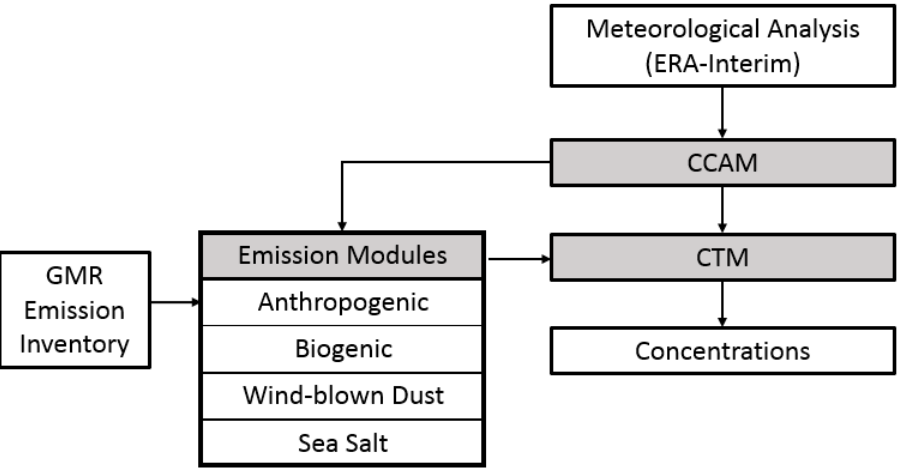
Figure 1. Schematic diagram of the CCAM ‐ CTM modelling system.